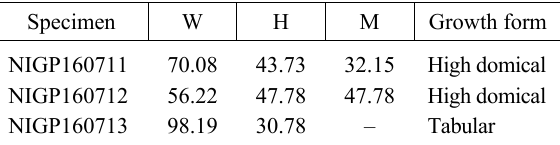
Table 1. Corallum size and shape of Halysites gaojiangensis sp. nov. W = corallum width (mm), H = corallum height (mm), M = height to the colony(cid:146)s widest point (mm)